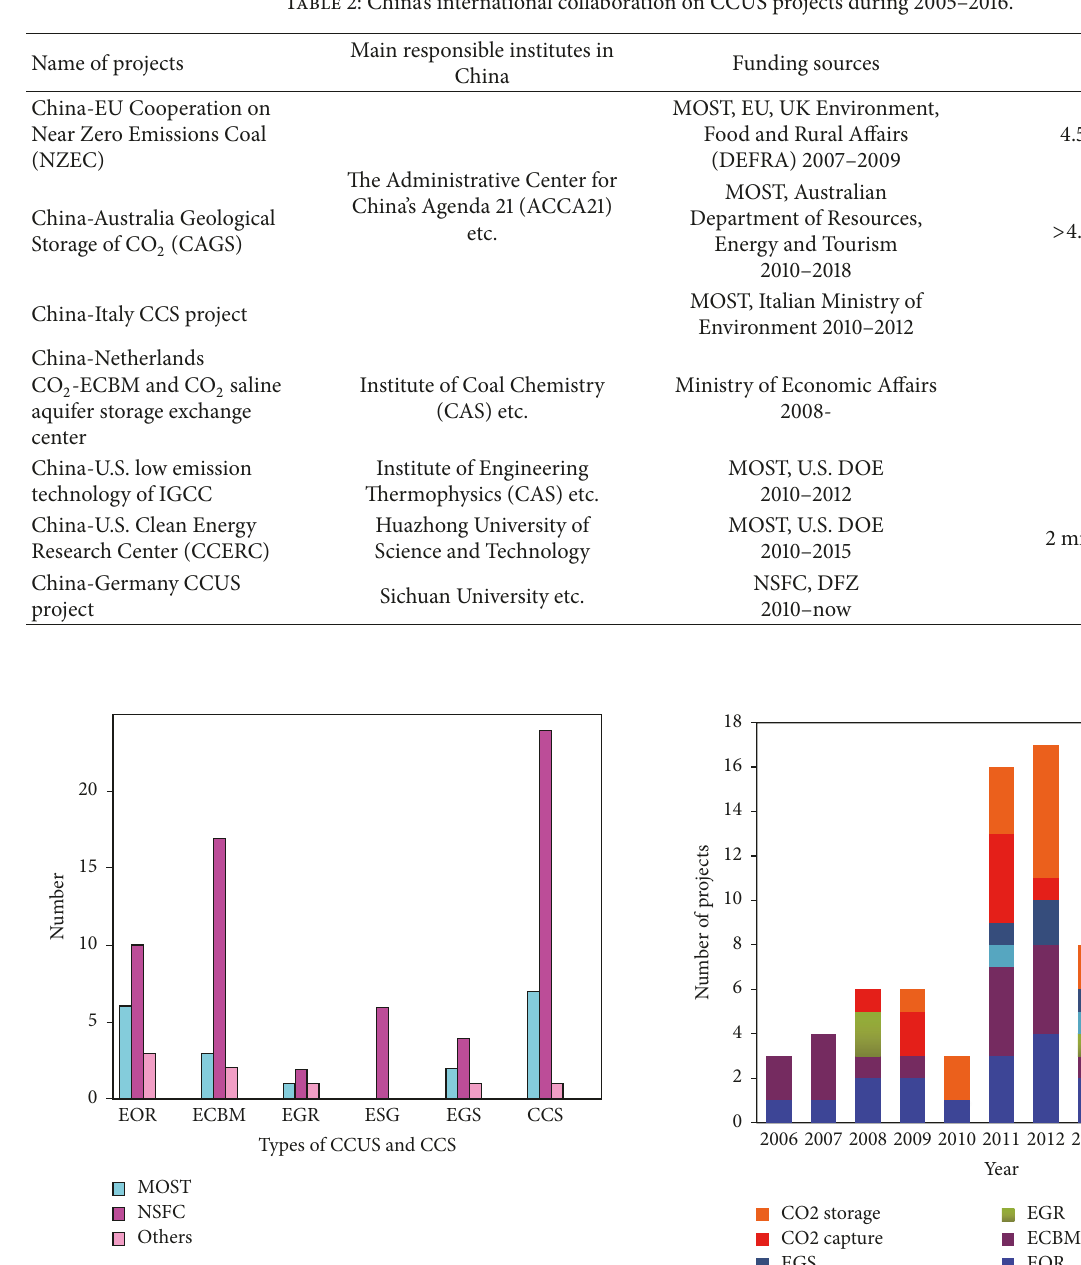
Figure 4: Research projects of CCS and CCUS in China during 2005–2016 based on Table 1.